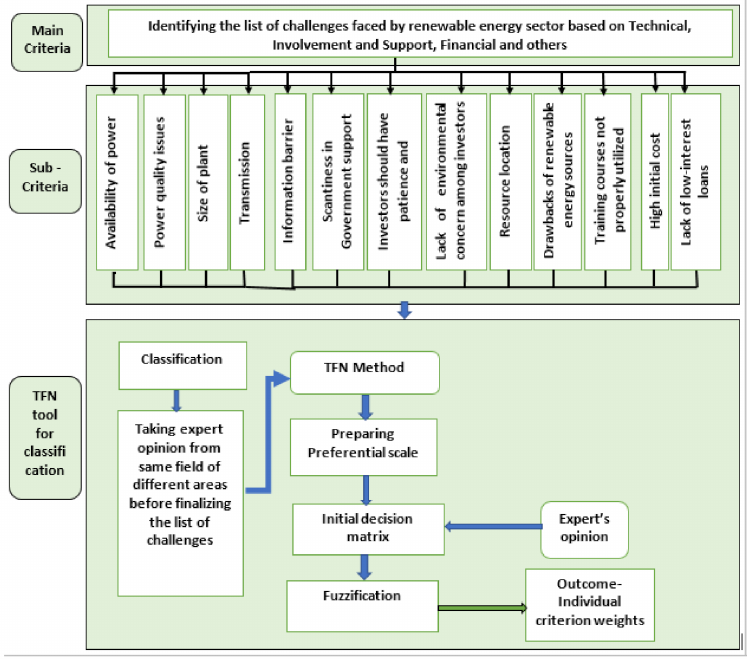
Figure 1. Workflow to identify and assess challenges in the renewable energy